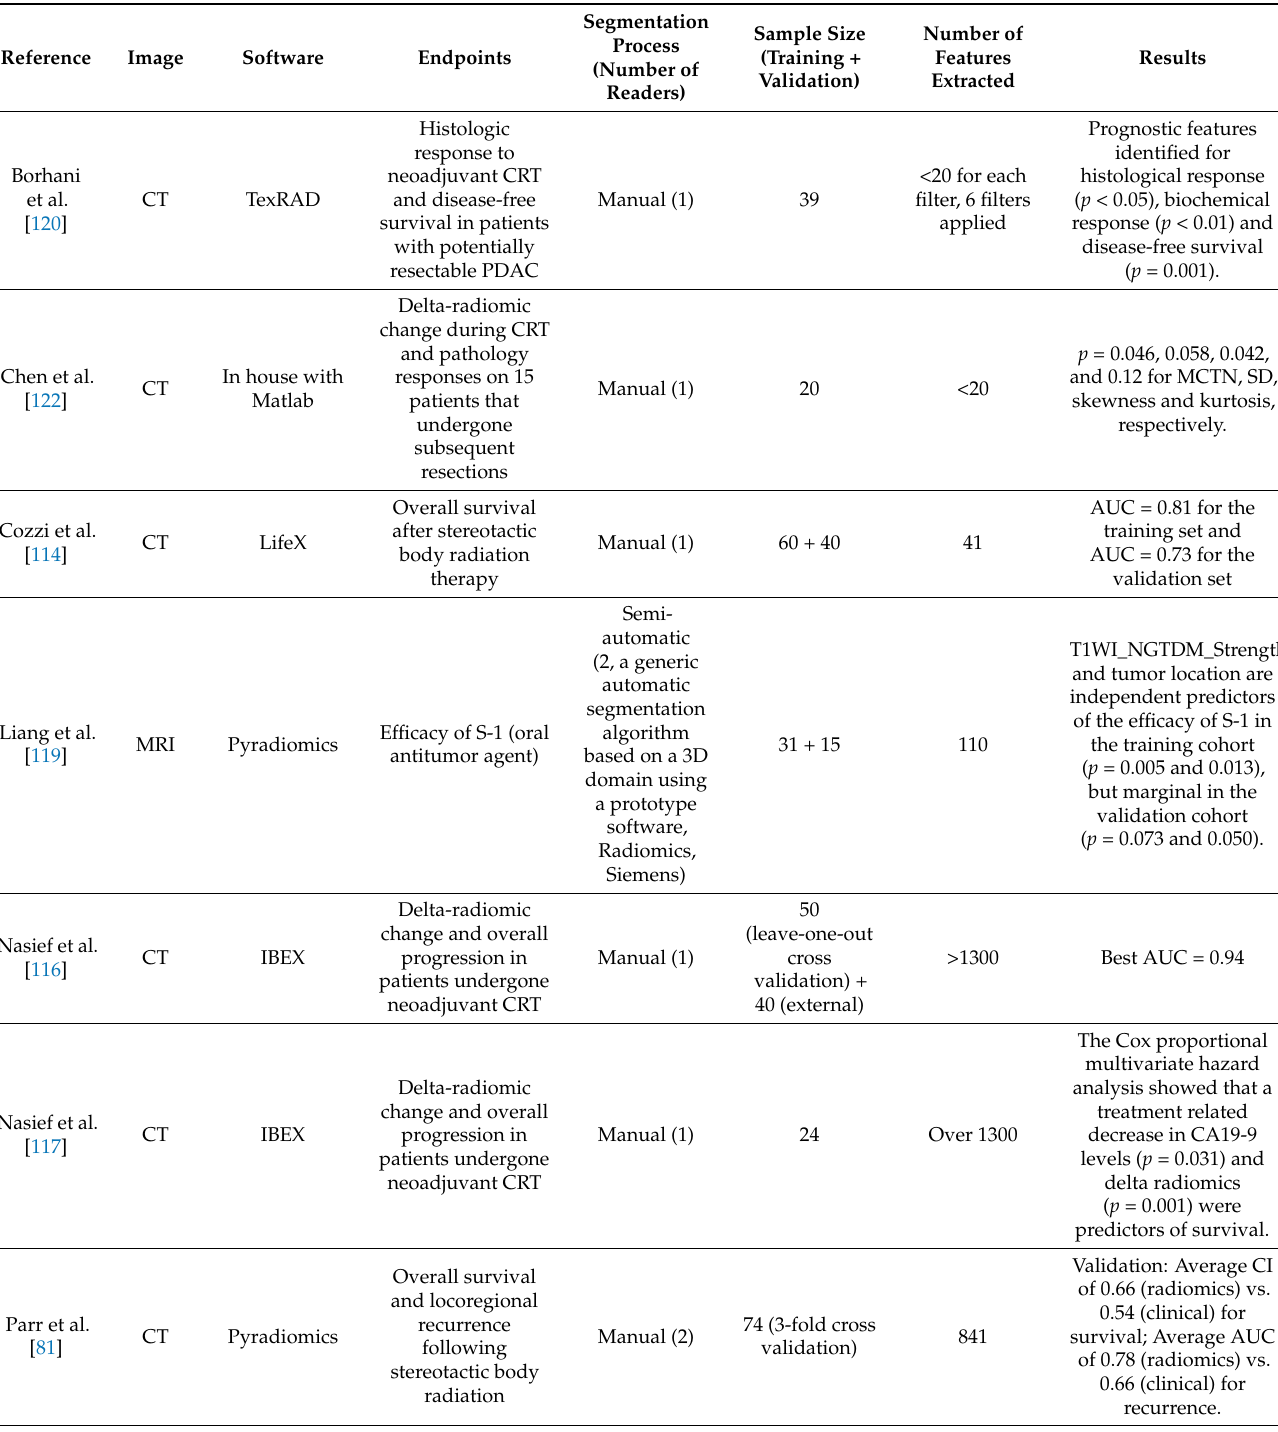
Table 7. Radiomics and deep learning studies in treatment stratification, delta-radiomics, and radiogenomics in pancreatic